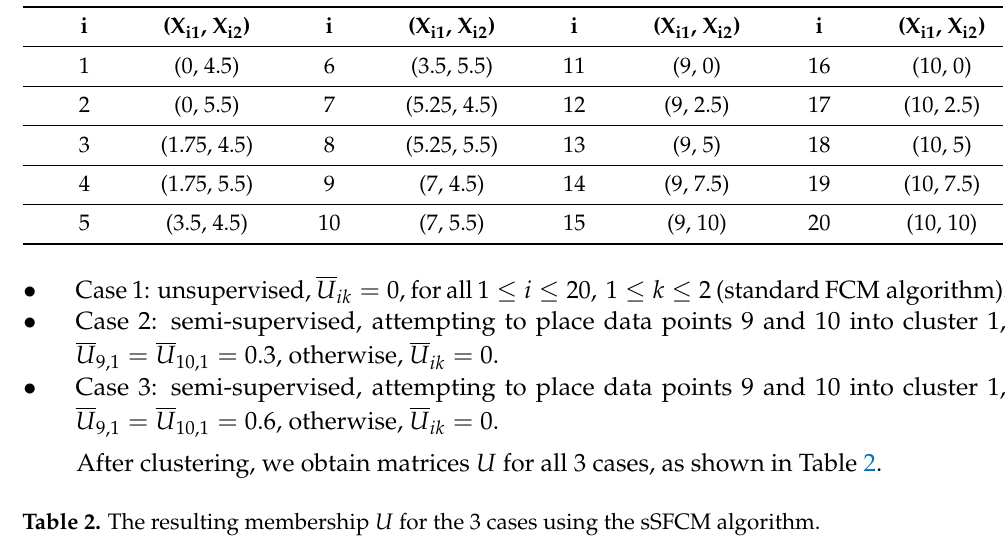
Table 1. Sample data set.